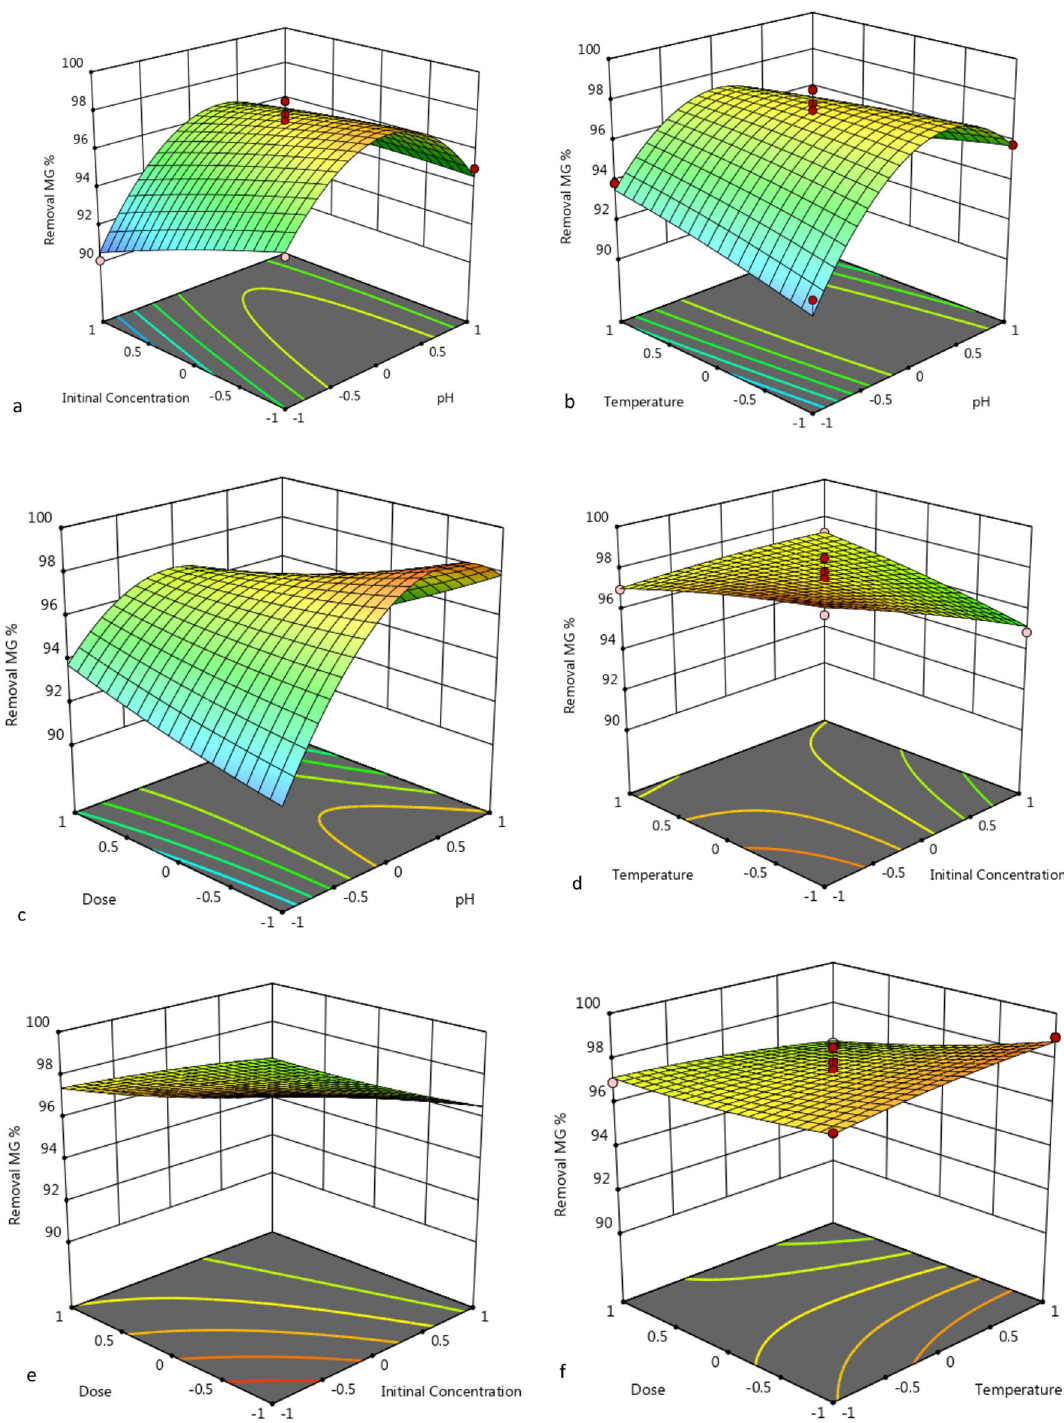
Figure 13. 3D response surface plot of MG removal % through MgO impregnated clay as a function of pH, temperature and adsorbent